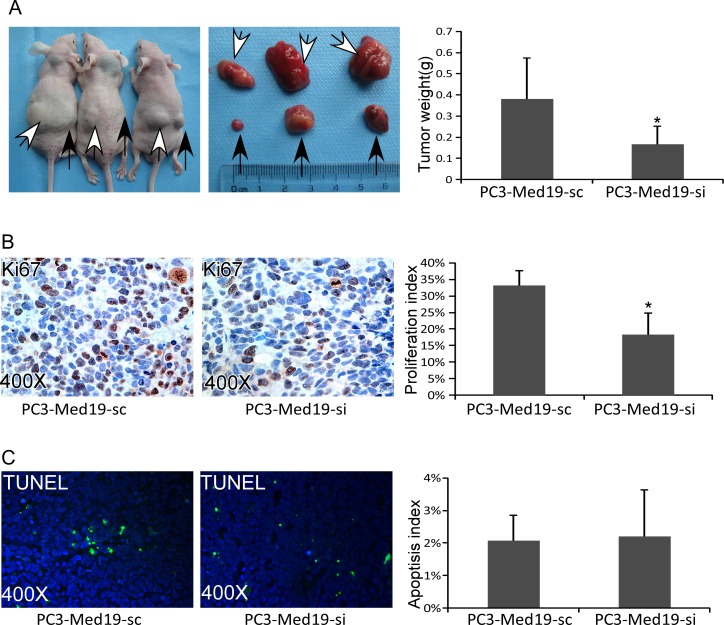
Knockdown of Med19 inhibited PCa progression in nude mice.(A) Six weeks after inoculation, PC3-Med19-si (black arrows showed tumors in the right flank) and PC3-Med19-sc (white arrows showed tumors in the left flank) formed tumors in nude mice. The weight of PC3-Med19-si and PC3-Med19-sc tumors was 0.17±0.08g v.s. 0.38±0.19g (n = 6, *P<0.05). (B) In Ki67 IHC staining, the PC3-Med19-si tumors had fewer positive cells than PC3-Med19-sc tumors. The proliferation index was 18.30±6.55% in PC3-Med19-si tumors and 33.22±4.36% in control tumors (n = 6, *P<0.05). (C) In TUNEL assay, the apoptotic cells were similar in both tumors. The apoptosis index in PC3-Med19-si and PC3-Med19-sc tumors was 2.21±1.43% v.s. 2.08±0.78% (n = 6, P>0.1).